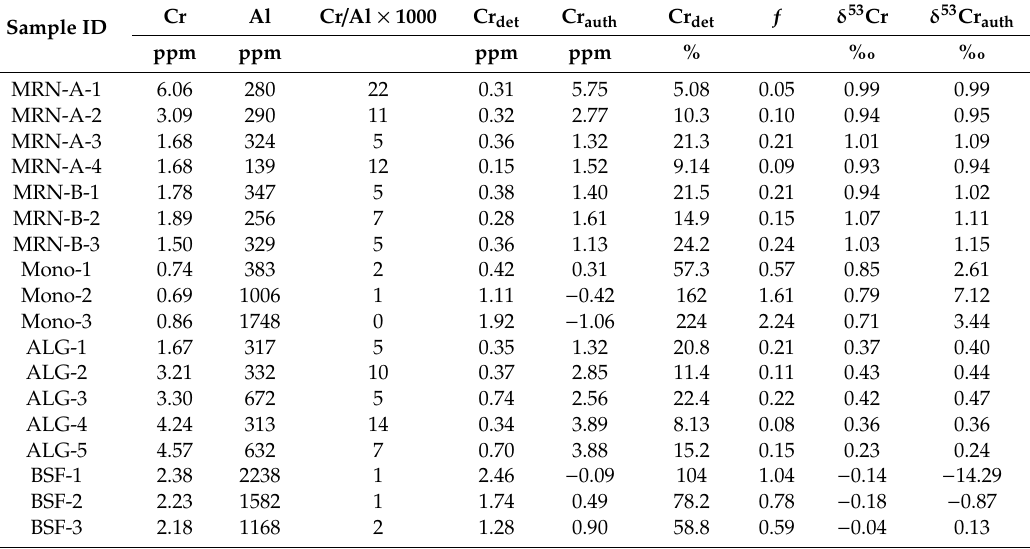
Figure 4. Cross-plot of ( a ) Cr and Al concentrations and ( b ) % of detrital Cr and (uncorrected) δ 53 Cr values. Table 3. Calculations for detrital correction of δ 53 Cr values using Al